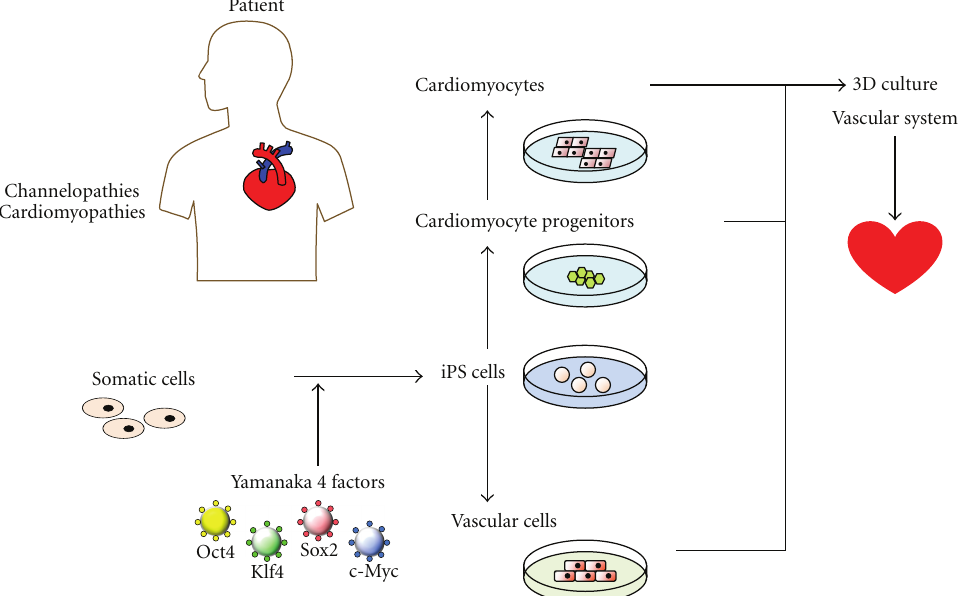
Figure 1: Whole concept of in vitro disease model for heart disease (channepathies and cardiomayopathies).